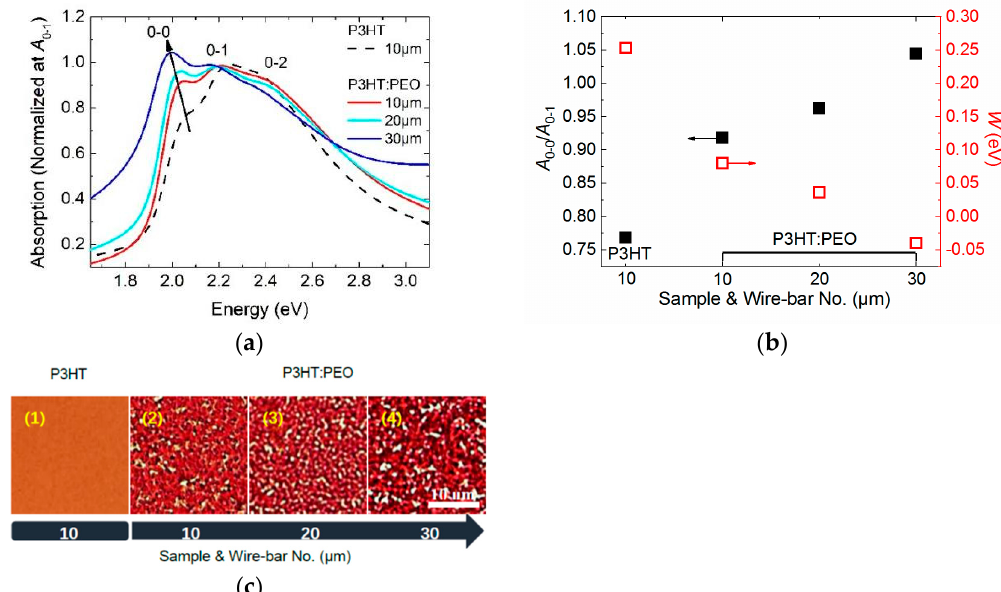
Figure 2. ( a ) Absorption spectra of poly (3-hexylthiophene-2,5-diyl) (P3HT) and P3HT: poly (ethylene oxide) (PEO) film prepared by wire-bar coating with various bars. The A 0-0 , A 0-1 , and A 0-2 vibronic features reflect transitions from the ground state to the first excited state. Absorption spectra are normalized at A 0-1 . ( b ) Vibronic transition ratios A 0-0 / A 0-1 and the interchain exciton bandwidth W are plotted as a function of bar sizes. A 0-0 / A 0-1 are deduced from the absorption spectra, and interchain exciton bandwidth W is calculated by Equation (1). ( c ) Optical microscopy images of P3HT and P3HT: PEO film coated with different bars.